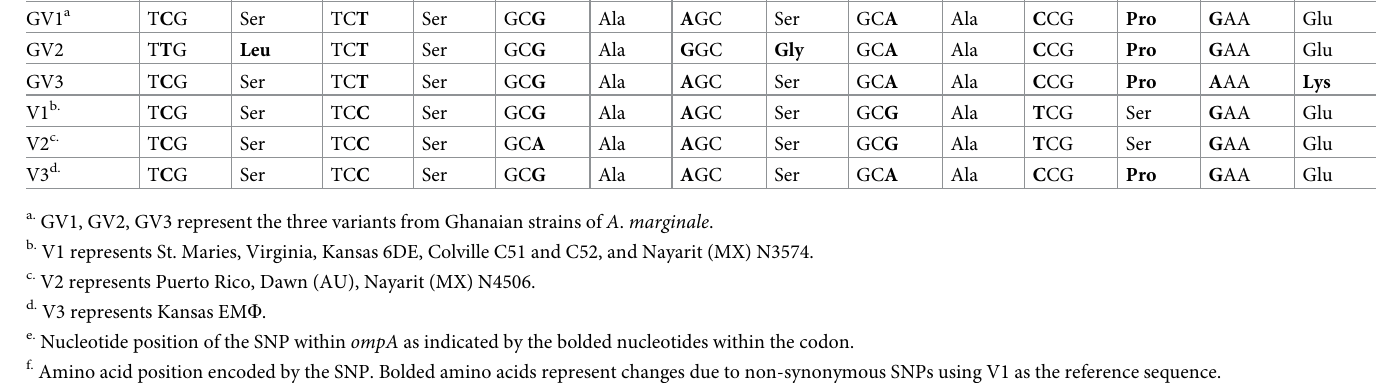
Table 1. Location of codons with SNPs and the corresponding encoded amino acid in ompA variants from Ghana, N. America, Mexico, Puerto Rico and Australia. Variant 335 e.